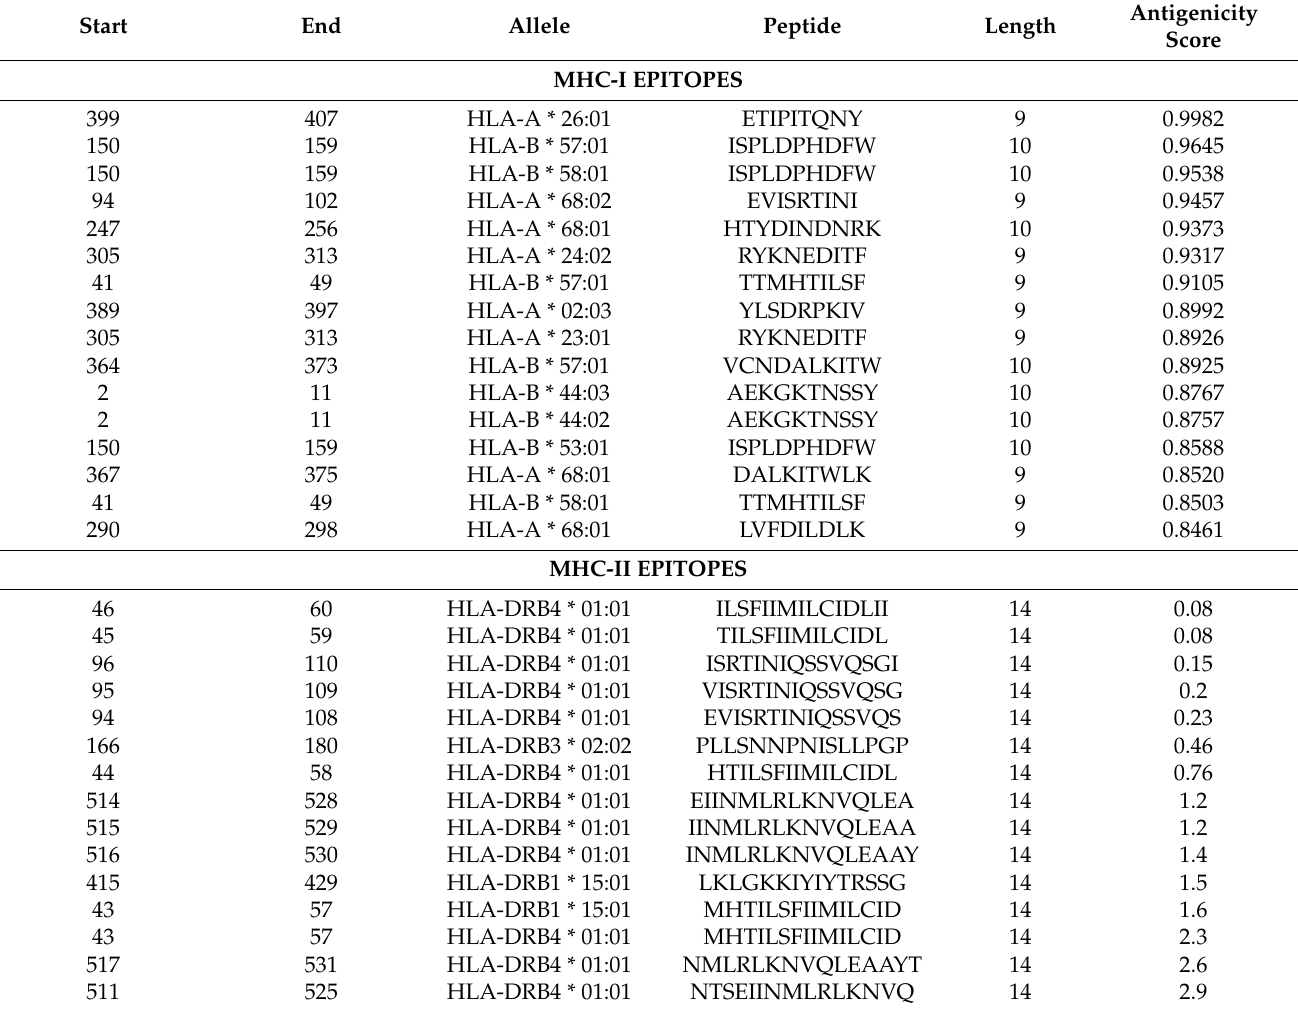
Table 3. Selected T-cell epitopes for the vaccine.